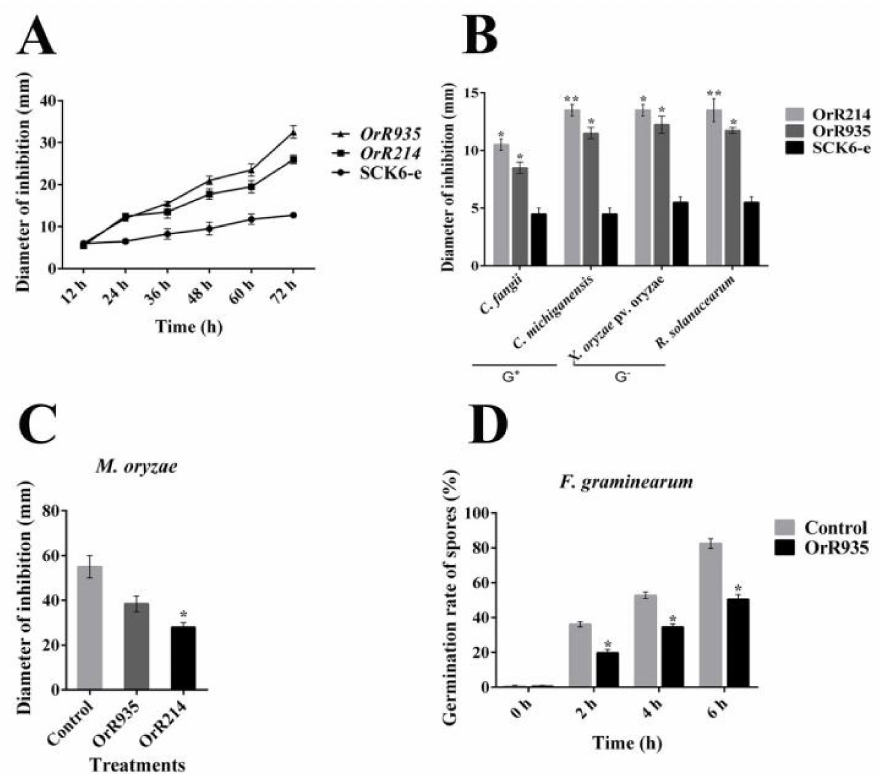
Figure 2. Analysis of antimicrobial potentiality of two resistance genes against pathogens. The B. subtilis SCK6-e strain was employed as a control in this assay. ( A ) Growth and di ff usion diameter of autolytic strains. ( B ) Both groups of bacterial inhibition compared with SCK6-e in response to peptides OrR214 and OrR935. ( C ) Inhibition of OrR214 and OrR935 peptides against M. oryzae compared to bu ff er. ( D ) Inhibition of the germination rate of OrR935 peptides against spores of F. graminearum compared to bu ff er. Three individual experimental data points were collected for the mean values. SD (standard deviation) is represented by vertical bars. T -tests were carried out to evaluate the significance levels at * p ≤ 0.05 and ** p ≤